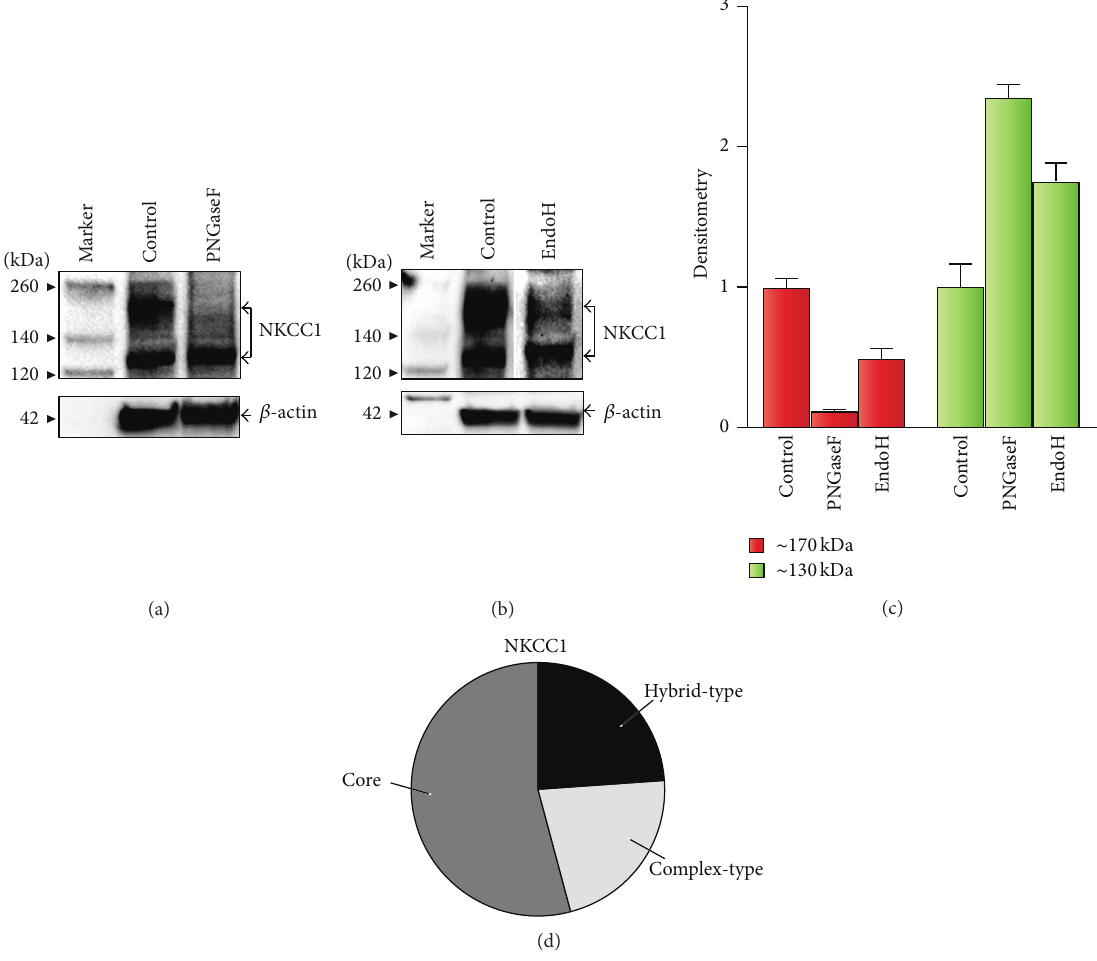
Figure 3: NKCC1 is expressed in COS7 cells as a core/high-mannose, hybrid- and complex-type N-glycosylated protein. ((a)-(b)) Representative immunoblots of protein extracts from COS7 cells grown under basal conditions. Untreated protein extracts (control) or enzymatically digested with PNGaseF (a) or EndoH (b) were immunoblotted and developed using ckNKCC1 coupled to HRP-conjugated secondaryantibodies.Asloadingcontrol,membraneswereprobedwithantibodiesagainst 𝛽 -actin.(c)Densitometryanalysisofimmunoblots of proteins control or treated with PNGaseF or EndoH. Shown are the estimated levels of the two main bands of NKCC1, that is, ∼ 170kDa (red bars) and ∼ 130kDa (green bars), before and after enzymatic deglycosylation. Data are expressed as means ± SEM ( 𝑛 = 5 ). (d) Pie- chart representing the approximate relative contribution of core/high-mannose, hybrid- and complex-type N-glycans to total endogenous NKCC1 in COS7 cells. Results are calculated based on the percent of increase in the densitometry signal of bands of ∼ 130kDa after enzymatic